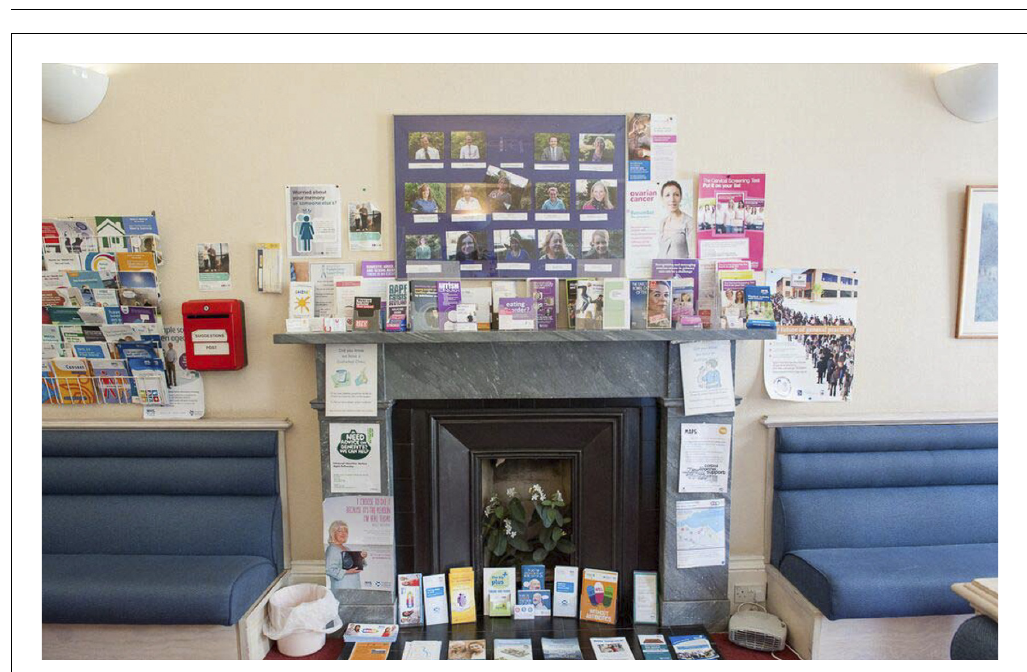
Figure 3. Leaflet